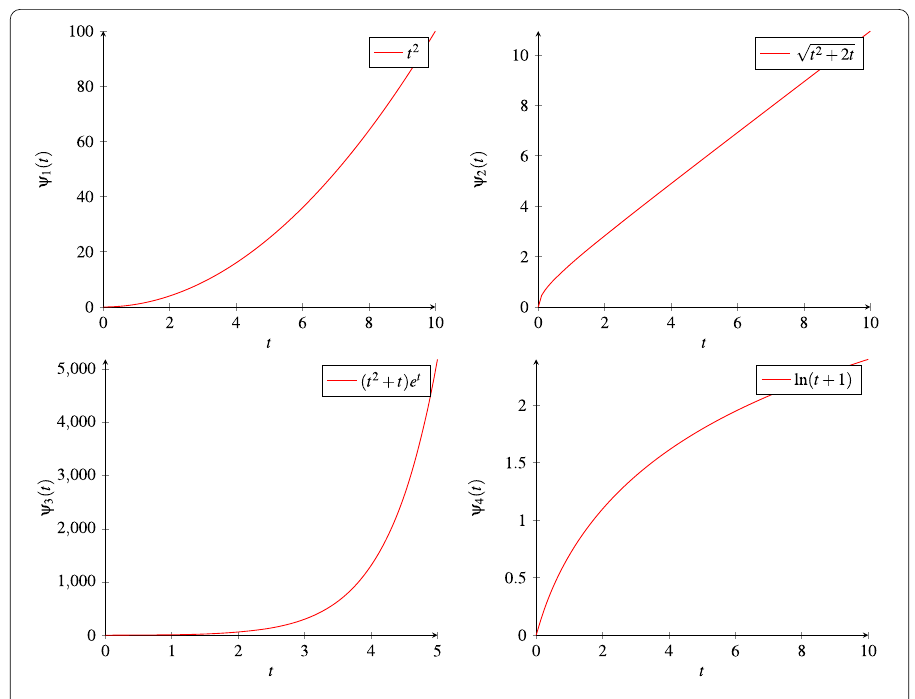
Figure 1 Graphs of ψ 1 , ψ 2 , ψ 3 , ψ 4 in Example